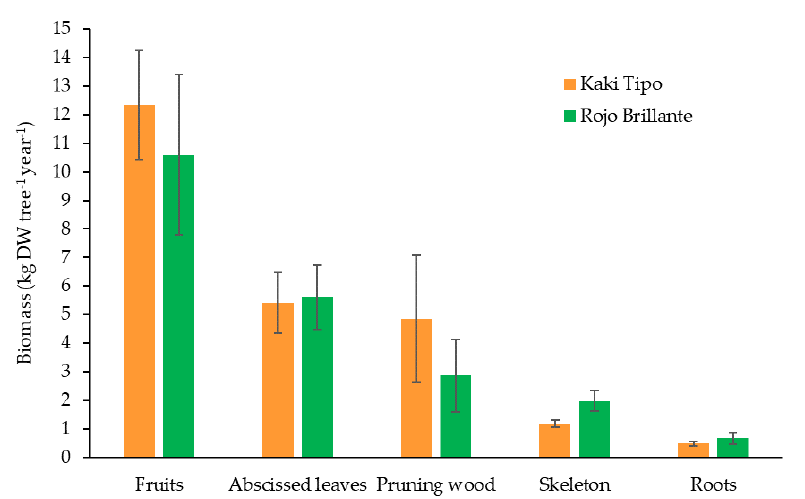
Figure 1. Annual production of biomass (DW) of mature persimmon tree of cultivar Kaki Tipo and Rojo Brillante. Bars are standard deviation ( n = 20 for new growth organs and 4 for perennial or- gans).